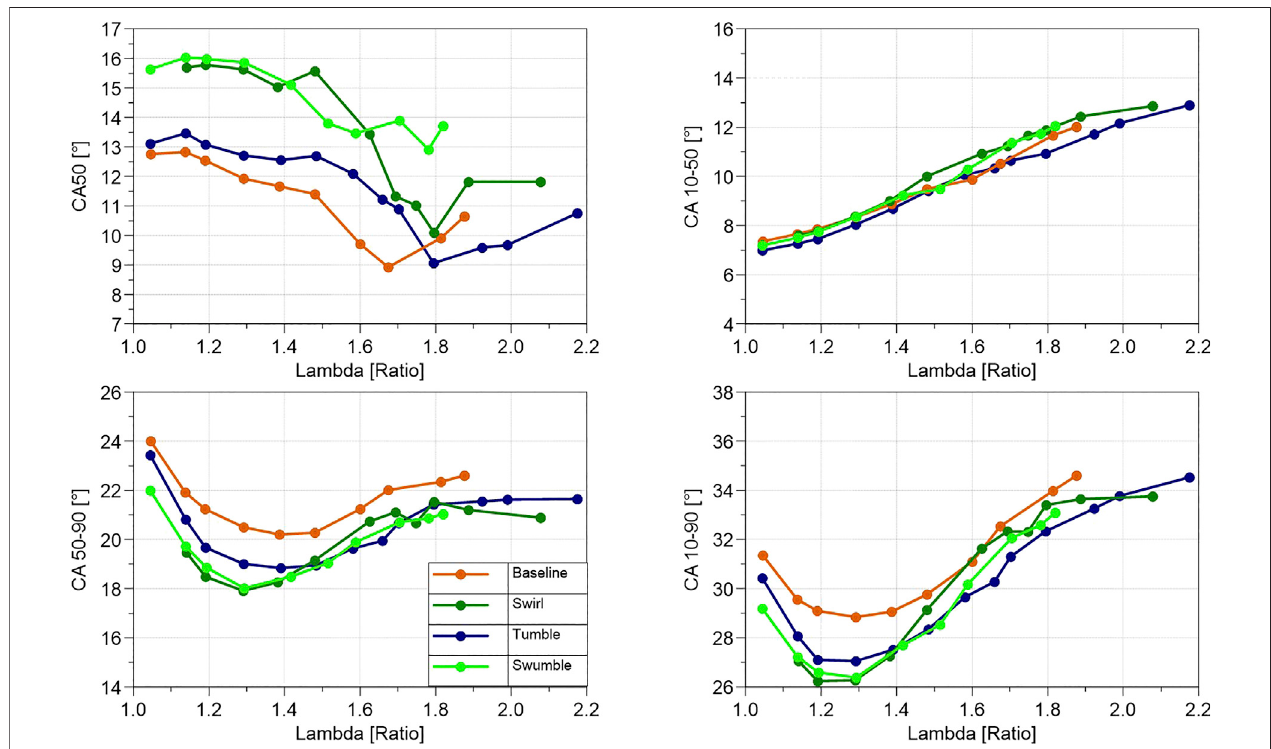
FIGURE 10 | Burn duration metrics vs. lambda; 3,000 rpm, 13.5 bar IMEPg.